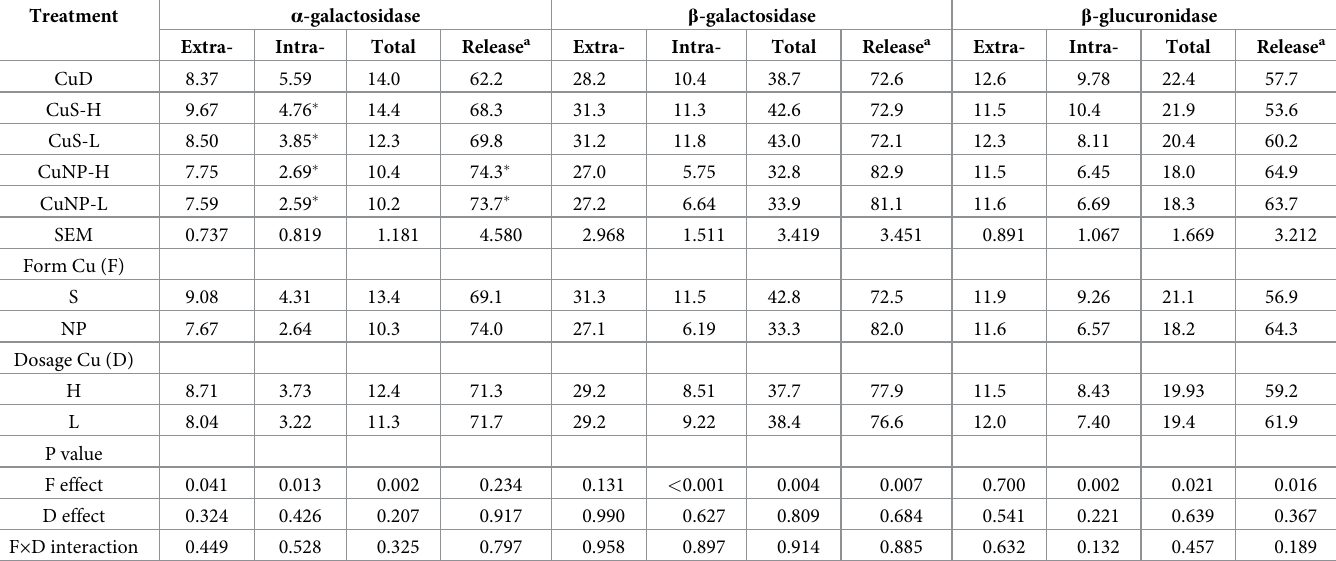
Table 7. Activity of microbial enzymes in caecal digesta of rats ( μ mol/h/g fresh caecal digesta). Treatment α -galactosidase β -galactosidase β -glucuronidase